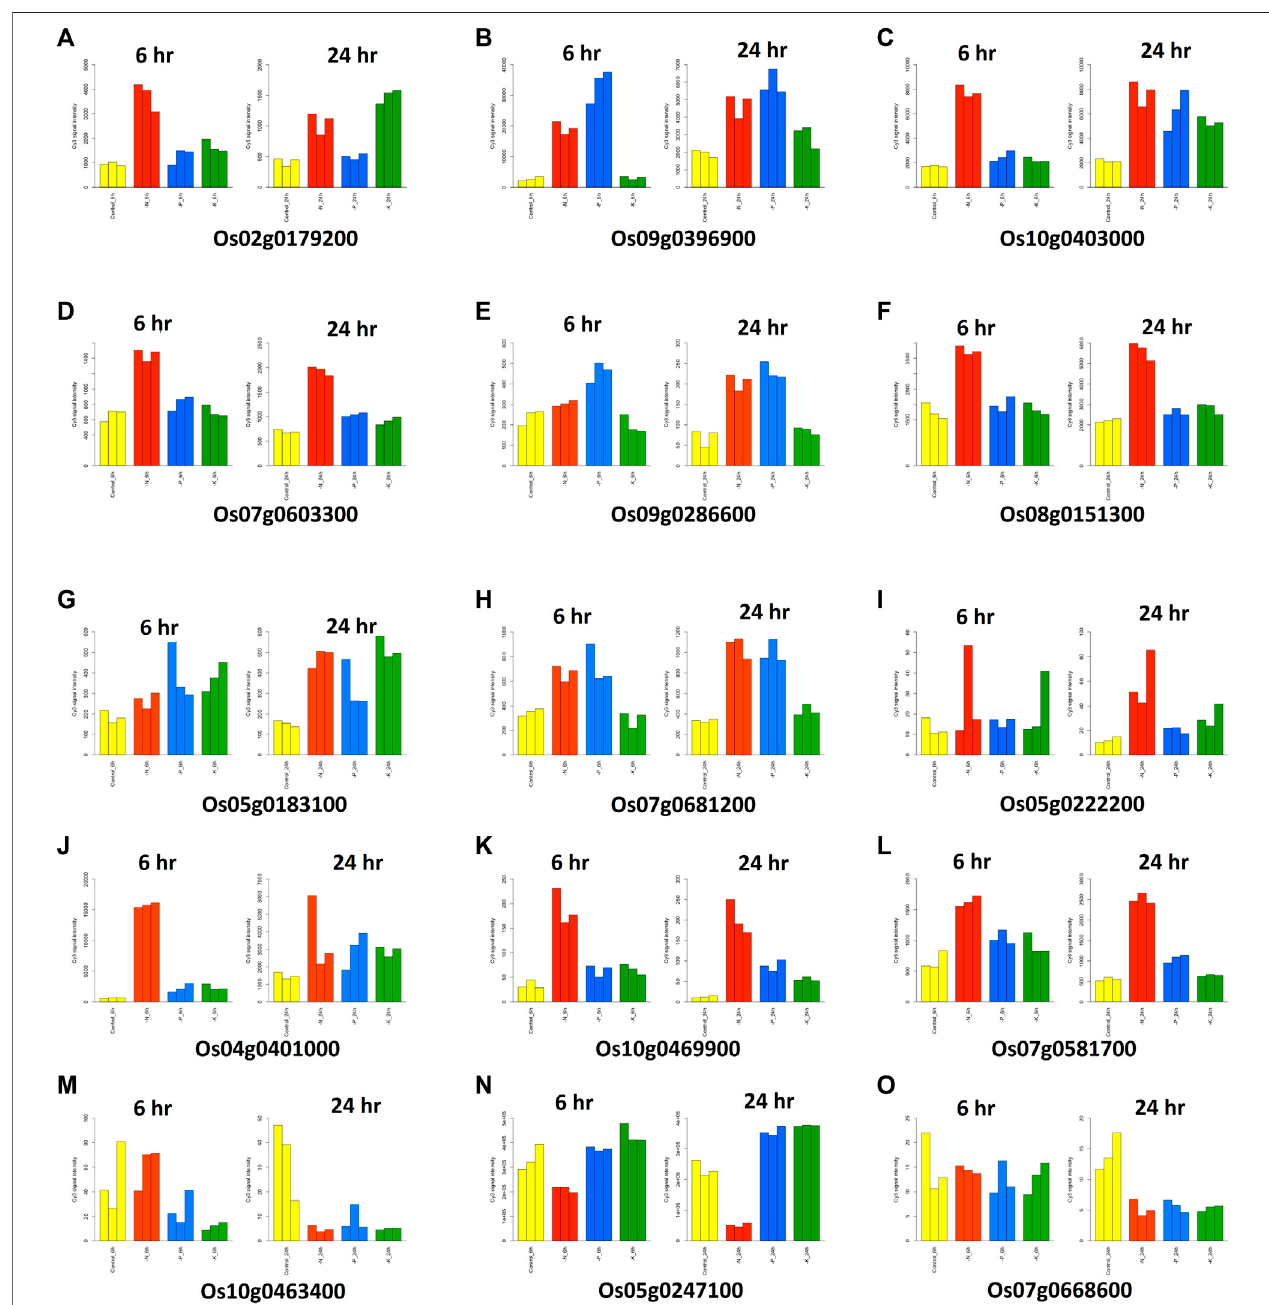
FIGURE 7 | Graphical representation of the signi fi cant changes in expression values of the candidate genes in response to nitrogen de fi ciencies in roots.